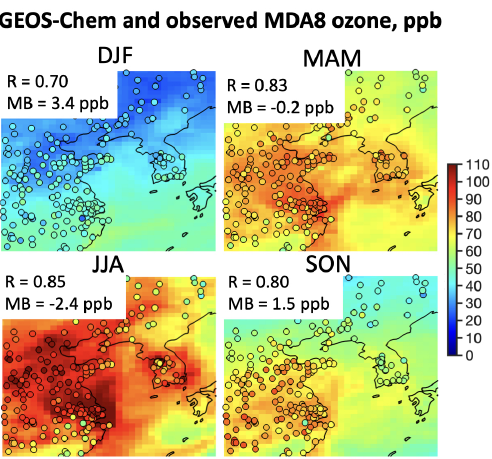
Figure 7. Monthly 90th percentile MDA8 ozone over South Ko- rea and China for different seasons in 2016. GEOS-Chem model results for each season (background contours) are compared to AirKorea and MEE network observations (symbols); 50% of network sites have been culled randomly for visualization pur- poses. The GEOS-Chem correlation coefficient ( R ) and mean bias (MB) relative to observations are shown inset. DJF: